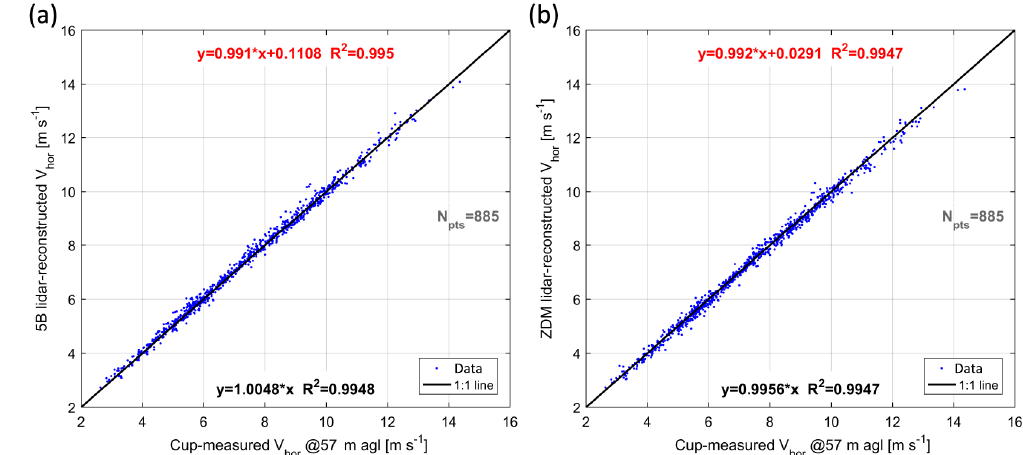
Figure 8. Comparison between mast-measured and lidar-estimated horizontal wind speed at 57.5m heighta.g.l. (a) 5B-Demo lidar, using five LOS, at 2 . 0 D rot . (b) ZDM lidar, using six LOS, at 2 . 5 D rot